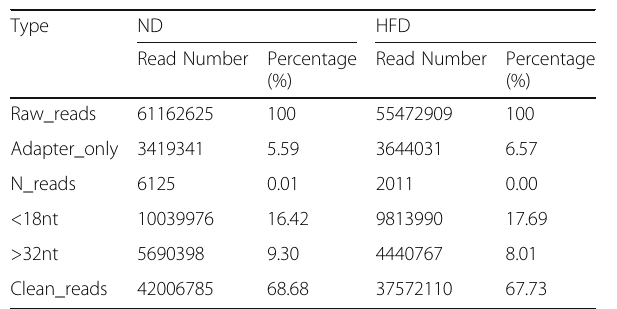
Table 1 Results of raw reads before and after quality control of ND and HFD libraries